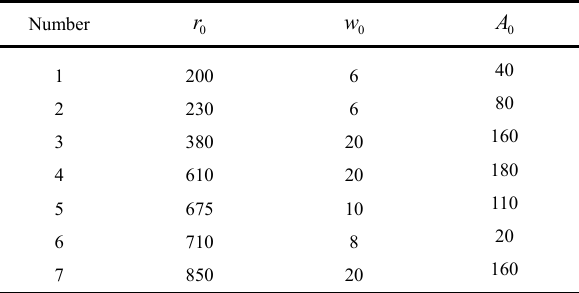
Table 1 Parameters of Lorentzian function used for the synthetic Raman spectrum.